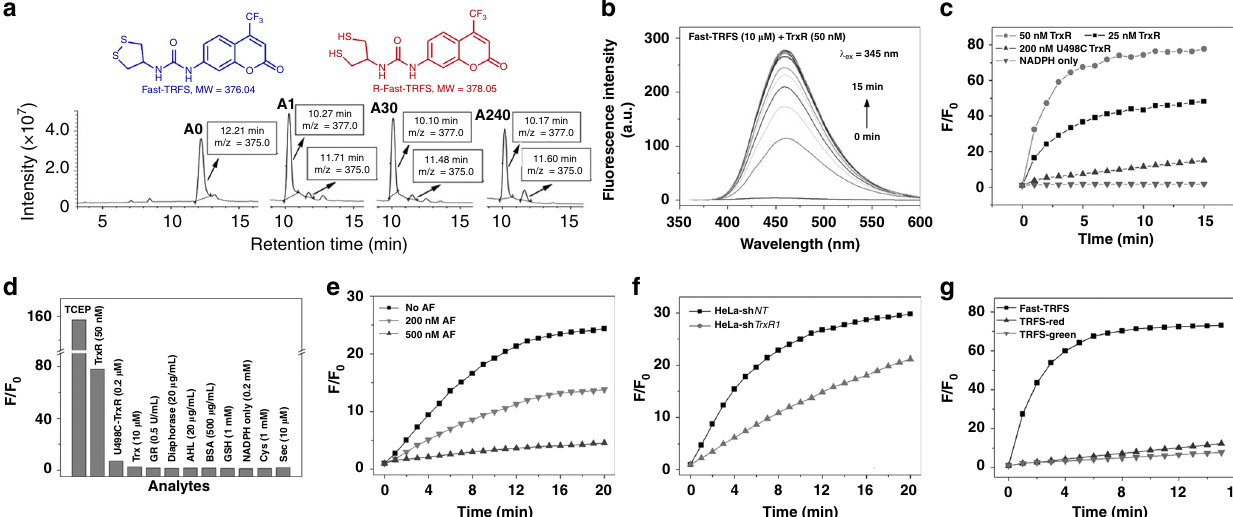
Fig. 6 Reduction of Fast-TRFS (TRFS9) by TCEP and Selective activation of Fast-TRFS by TrxR. a Reduction of Fast-TRFS by TCEP. Fast-TRFS (100 μ M) was incubated with TCEP (1 mM) for 0 min ( a 0), 1 min ( a 1), 30 min ( a 30) and 240 min ( a 240), and the mixture was analyzed by HPLC-MS. b Time-dependent emission spectra of Fast-TRFS toward TrxR. Fast-TRFS was incubated with TrxR/NADPH (50 nM/200 μ M), and the emission spectra were recorded every 1 min for 15 min. c Time course of the fl uorescence increase of Fast-TRFS with TrxR/NADPH and U498C TrxR/NADPH. d Response of Fast-TRFS to various relevant biological species. The fl uorescence increase at 460 nm was determined after they were incubated with Fast-TRFS for 15 min. The Sec (10 μ M) was generated in situ by mixing Cys (1 mM) and selenocystine (5 μ M). e Inhibition of the cell lysate-mediated Fast-TRFS reduction by TrxR inhibitor AF. The NADPH-pretreated HeLa cell lysate (0.5 mg mL − 1 ) was treated with AF for 30 min, and further incubated with Fast-TRFS and NADPH (200 μ M) for additional 20 min. The fl uorescence increase was determined. f Reduction of Fast-TRFS by lysates (0.5 mg mL − 1 ) from the genetically manipulated HeLa cells in the presence of NADPH (200 μ M). g Time course of the fl uorescence increase of Fast-TRFS, TRFS-red and TRFS-green with TrxR/NADPH (50 nM/200 μ M). All reactions were performed in TE buffer at 37 °C. The excitation/emission wavelengths for Fast-TRFS, TRFS-green and TRFS-red are 345/460nm, 438/538 nm and 615/661 nm, respectively. The concentration of the probes in ( b – g ) was 10 μ M. Source data are provided